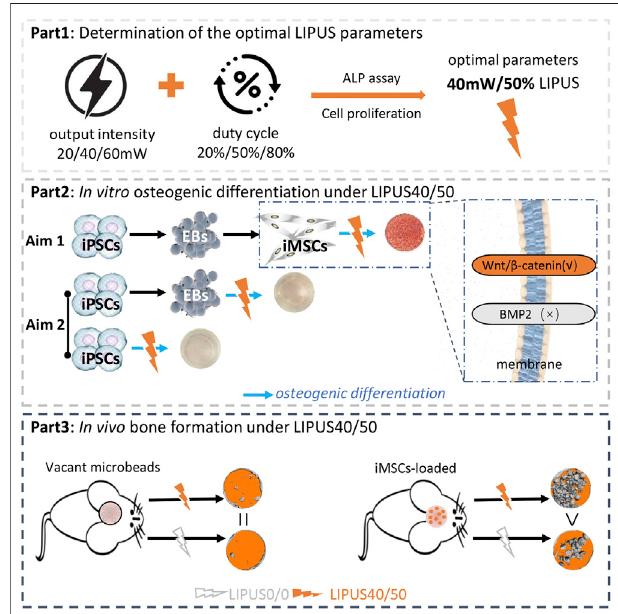
GRAPHICAL ABSTRACT | We demonstrate LIPUS at the intensity of 40mW/cm 2 and the D.C of 50% (LIPUS40/50) can enhance the osteogenic potential of iMSCs in vitro and in vivo. LIPUS40/50 seems to accelerate EB- iMSC transition, but itfails to convert iPSCs or EB cells into osteoblasts directly. These results represent an important step toward applying iPSCs safely and effectively in bone tissue